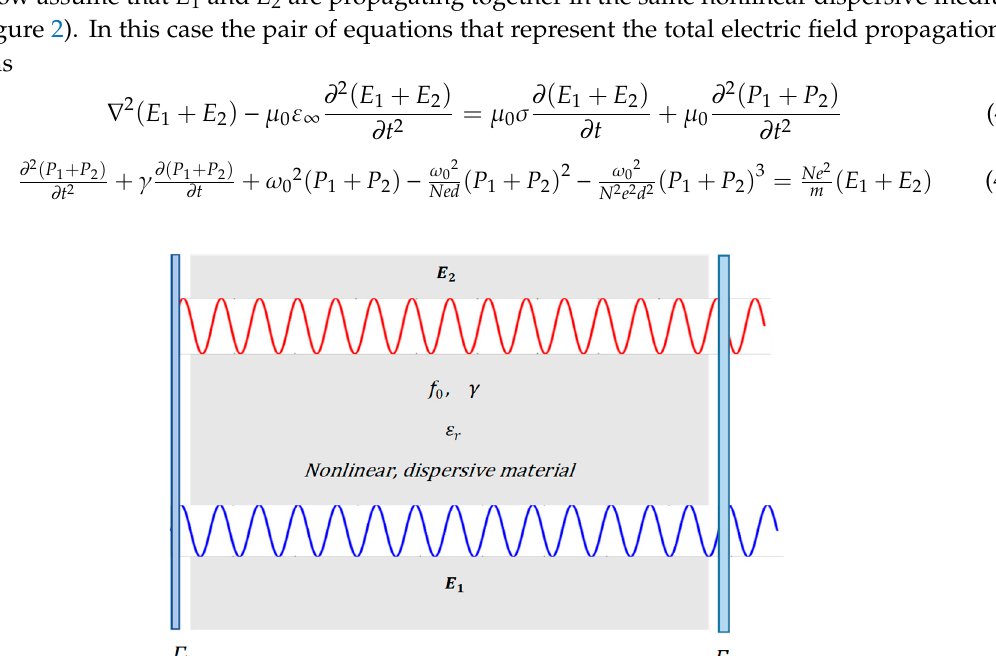
Figure 2. Two waves are propagating through a nonlinear dispersive medium placed in a cavity.